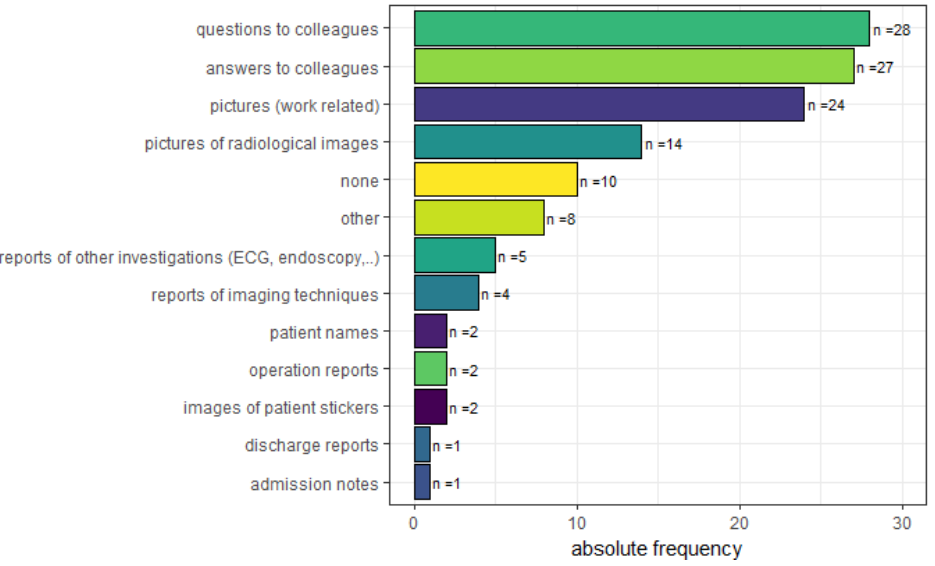
Figure 5. The figure shows the answers to the following multiple-choice question: “What types of clinical information do you ever put on communication apps for clinical purposes? (You can choose more than 1 respons e)” .